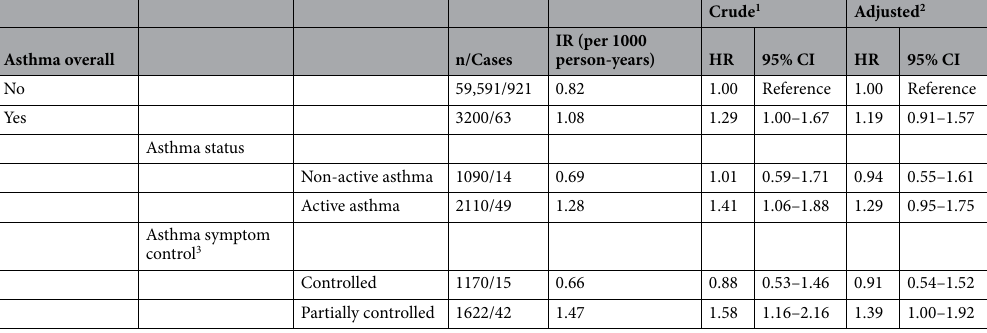
Table 2. The associations of asthma overall, asthma status and levels of asthma symptom control with lung cancer incidence, the HUNT Study, 1995–97 to 2017 (n = 62,791). CI: confidence interval; HR: hazard ratio; IR: incidence rate. 1 Age was used as the time scale in the crude model. 2 Adjusted for sex, body mass index, smoking [(never, former (< 10, 10–20, and > 20 pack-years (pyrs)), current (< 10, 10–20, and > 20 pyrs)], passive smoking, alcohol consumption, physical activity, total sitting time daily, education, economic difficulties, family history of cancer and allergic rhinitis. Age was used as the time scale. Tvc option of the stcox command in Stata was used to model the non-proportional hazards for sex, smoking and economic difficulties in the adjusted models. 3 An “unknown” level of asthma symptom control is not shown due to limited lung cancer cases (n = 6).